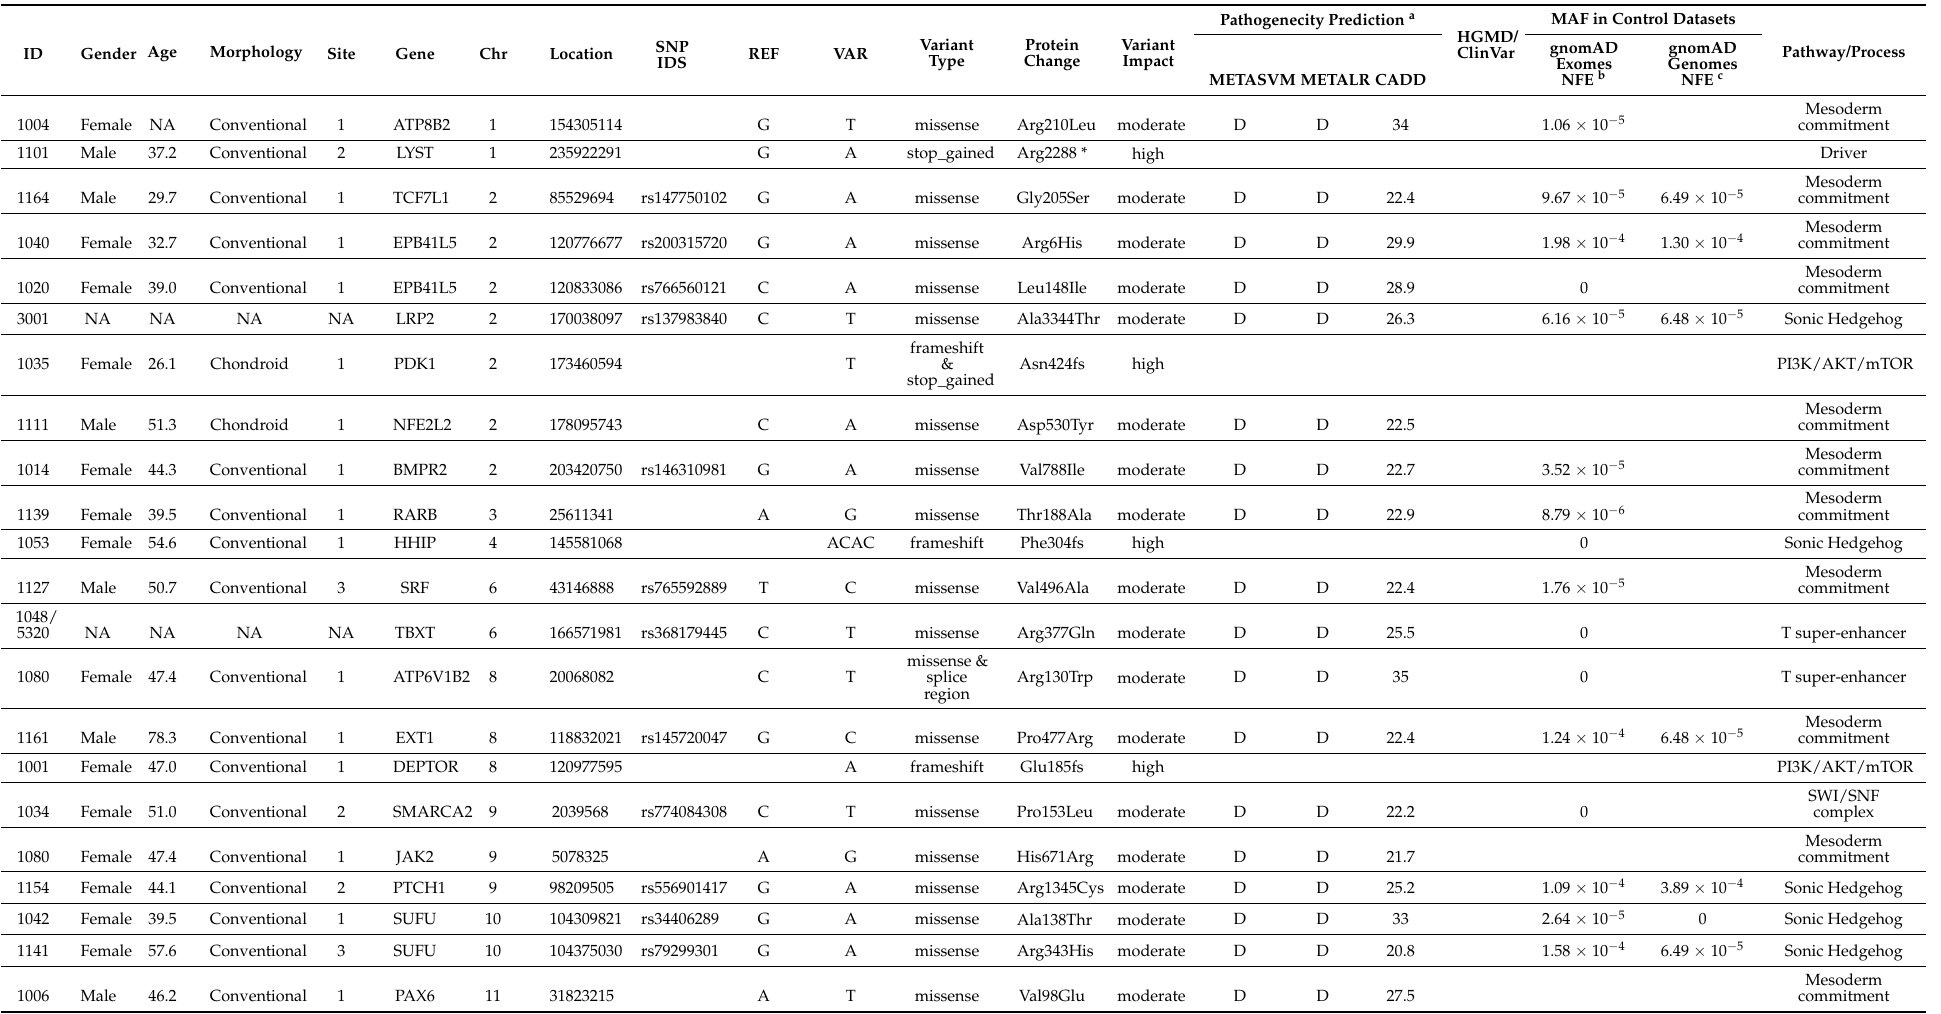
Table 1. Information on rare variants identified in the European ancestry patients after the prioritization